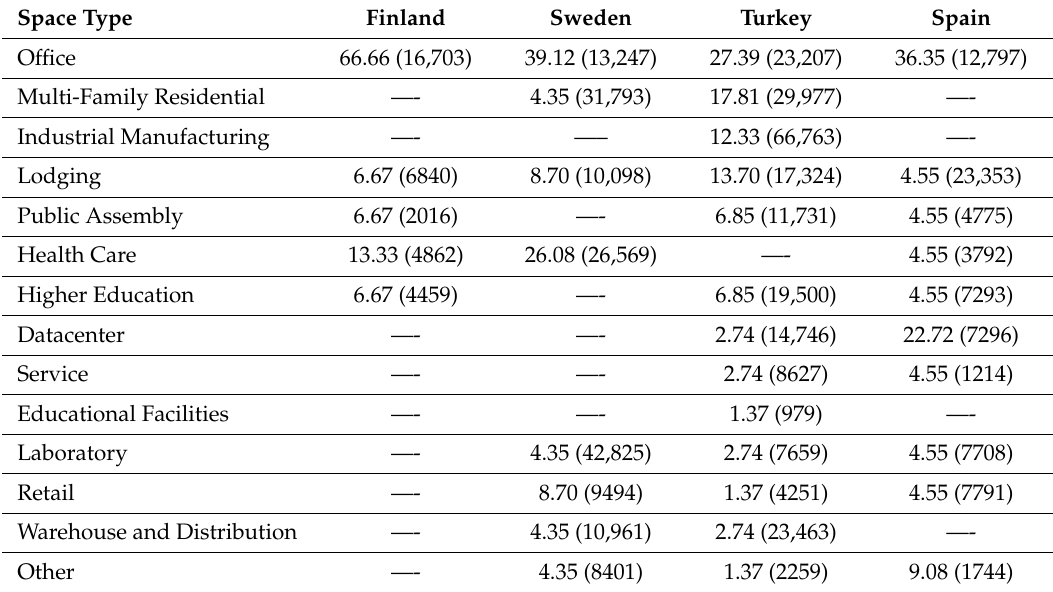
Table 2. Space type in % of total number of projects and an average of the current project size in (m 2 ). Space